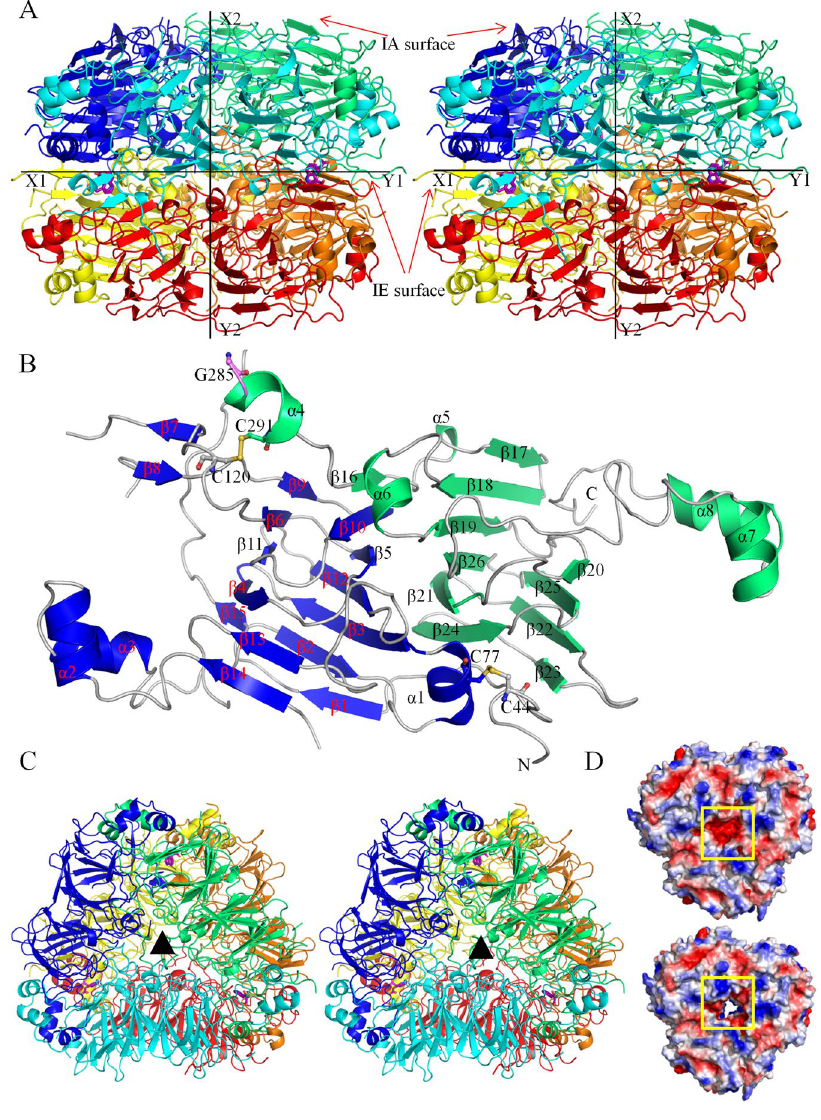
Figure 1. The overall architecture of 11S globulin from Wrightia tinctoria . ( A ) The stereoview of the two-fold axis of symmetry of WTG hexamer. The X1-Y1 axis represents the two-fold axis of symmetry between the two trimers of WTG. The X2-Y2 axis represents the threefold axis of symmetry present in the trimers of WTG. The IA and IE surfaces of the trimers have been indicated by red arrows. All the chains of the WTG hexamer are represented in cartoon form. Six monomers are shown in blue (chain A), green (chain B), cyan (chain C), yellow (chain D), red (chain E), and orange (chain F). ( B ) The WTG monomer depicting acidic subunit (blue) and basic subunit (green) having 26 β -sheets and 8 α -helices. The Gly285 asparaginyl endopeptidase cleavage site, intra-subunit (Cys44-Cys77) and inter-subunit (Cys120-Cys291) disulphide bonds are represented as ball-and- stick. The extended alpha helix and bicupin fold have been indicated. ( C ) The stereoview of the three-fold axis of symmetry of WTG trimer from the top. The triangle represents the axis perpendicular to the three-fold axis of symmetry. ( D ) The electrostatic surface potential of intra-subunit (IA) surface of trimer ABC in the presence and absence of Ser27-Ser34 residues, respectively. The region covers the hydrophilic channel formed at the center of the trimer (yellow